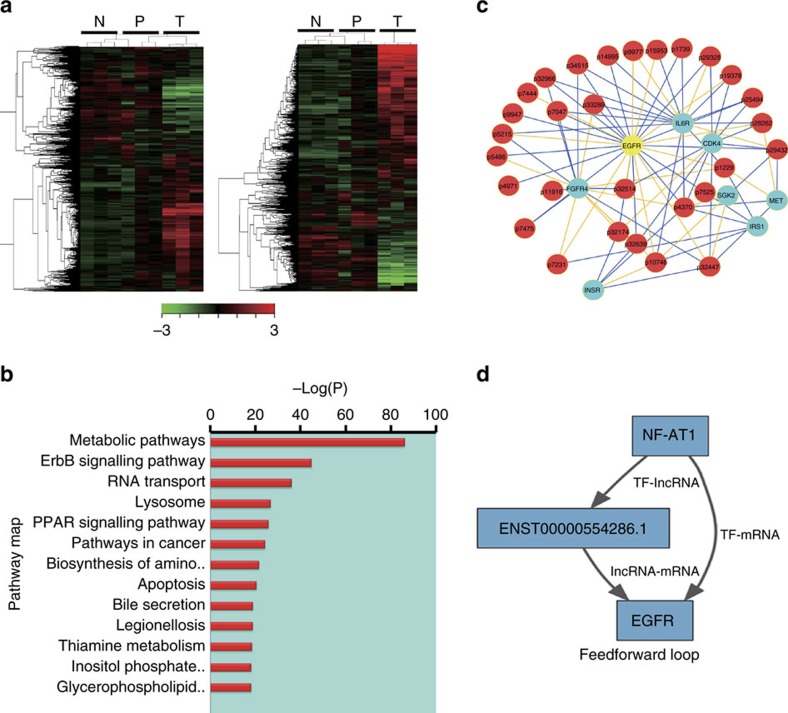
Landscape of mRNA and lncRNA expression in CD4+ T cells from TBLs and PBLs of human HCC patients.(a) Hierarchical clustering analysis of 1,251 lncRNAs (left panel) and 2,012 mRNAs (right) that are differentially expressed (the threshold of significance was defined by P<0.05 (with Student t-test) and the false discovery rate) in tumour-infiltrating CD4+ T cells (T), paired peripheral blood CD4+ T cells (P), and peripheral blood CD4+ T cells from healthy controls (N). The clustering tree for lncRNAs and mRNAs is shown at the top. The expression values are shown in shades of red and green, indicating expression above and below the median expression value across all the samples (log scale 10, from –3 to +3), respectively. (b) Pathway analysis showing the significant pathways of the differentially expressed protein-coding genes (P<0.05 with Student t-test). (c) A portion of the co-expression network of the candidate lncRNAs and mRNAs representing the significant pathways. A green node represents one mRNA and a red node represents a lncRNA. (d) Predicted NF-AT1–lnc-EGFR–EGFR feed-forward loop.